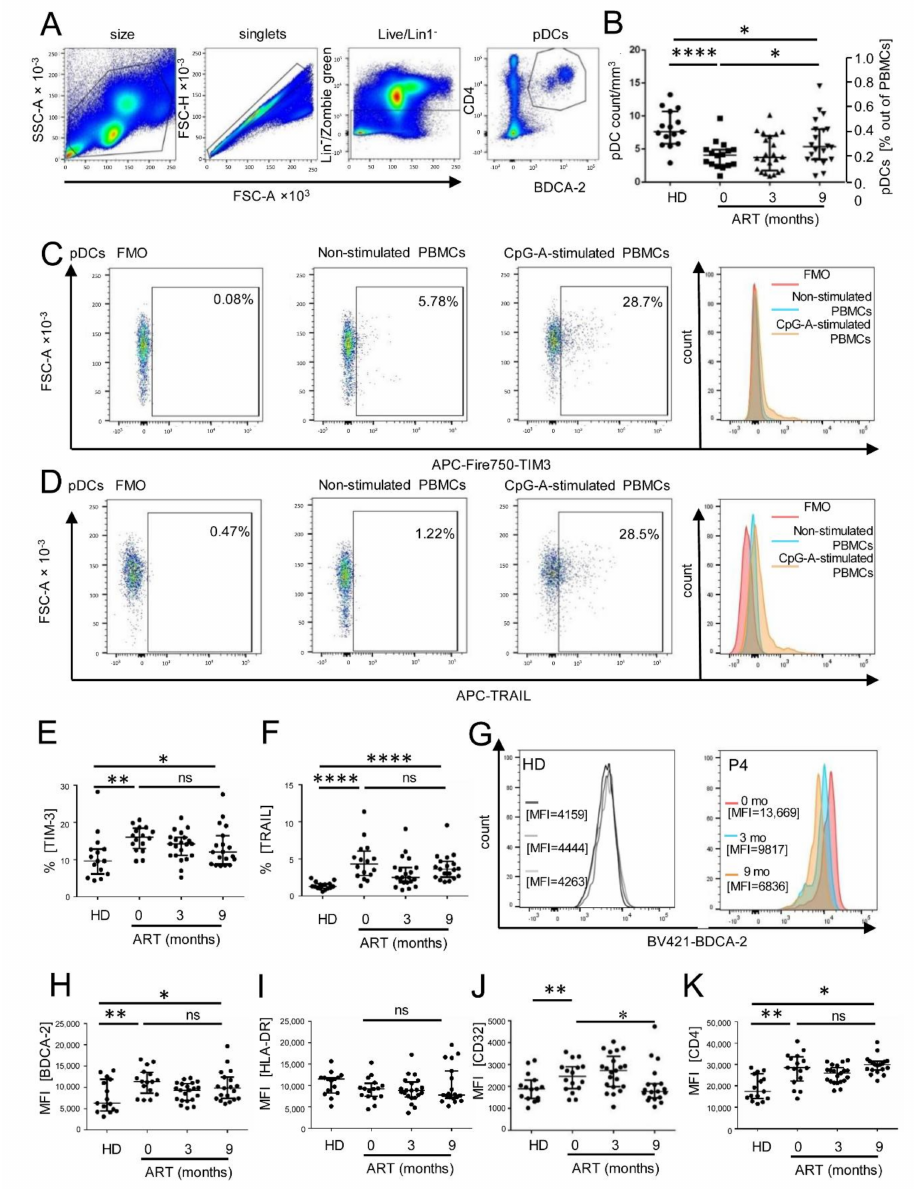
Figure 2. Impaired pDC phenotype persists after sustained suppression of HIV RNA in plasma of ART-treated patients. ( A ) Gating strategy for identification of pDC phenotype: PBMCs were gated according to their size and then into singlets, and after exclusion of dead cells (Zombie green) and Lin1 + cells into a CD4 + BDCA-2 + pDC population. ( B ) pDC number and proportion of PBMCs in healthy donors (HD) and in the course of ART. ( C , D ) Dot plots and histograms for the quantification of TIM3 ( C ) and TRAIL ( D ) in Lin − CD4 + BDCA-2 + live pDCs are shown. FMO was used for gating TIM-3 + ( C ) and TRAIL + ( D ) pDCs in mock-stimulated or CpG-A-stimulated PBMCs from a healthy donor and from HIV-1-infected patients ( E , F ). ( E ) The frequency of pDCs expressing TIM-3 in the cohort of 21 patients ( F ) The frequency of pDCs expressing TRAIL. ( G ) Examples of histograms for the quantification of BDCA-2 in three healthy donors (HD) and ART-treated patient no. 4 (P4) determined 0, 3, and 9 months after therapy initiation. ( H ) The MFI of BDCA-2 + expressed on pDCs. ( I ) The MFI of HLA-DR + expressed on pDCs. ( J ) The MFI of CD32 + expressed on pDCs. ( K ) The MFI of CD4 + expressed on pDCs. The data show medians and interquartile ranges. N = 21. * p < 0.05; ** p < 0.01; **** p < 0.0001; ns, non-significant; two-tailed Mann-Whitney